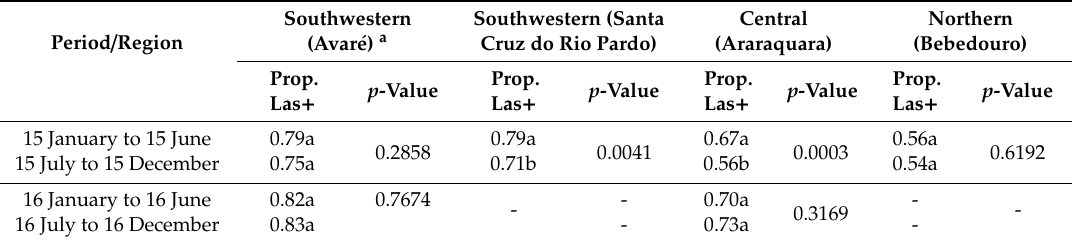
Table 3. Proportion of psyllids carrying Candidatus Liberibacter asiaticus (Prop. Las + ) in comparison between semesterly periods inside regions. Period / Region